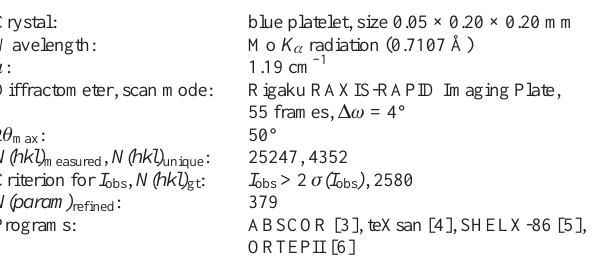
Table 1. Data collection and handling.